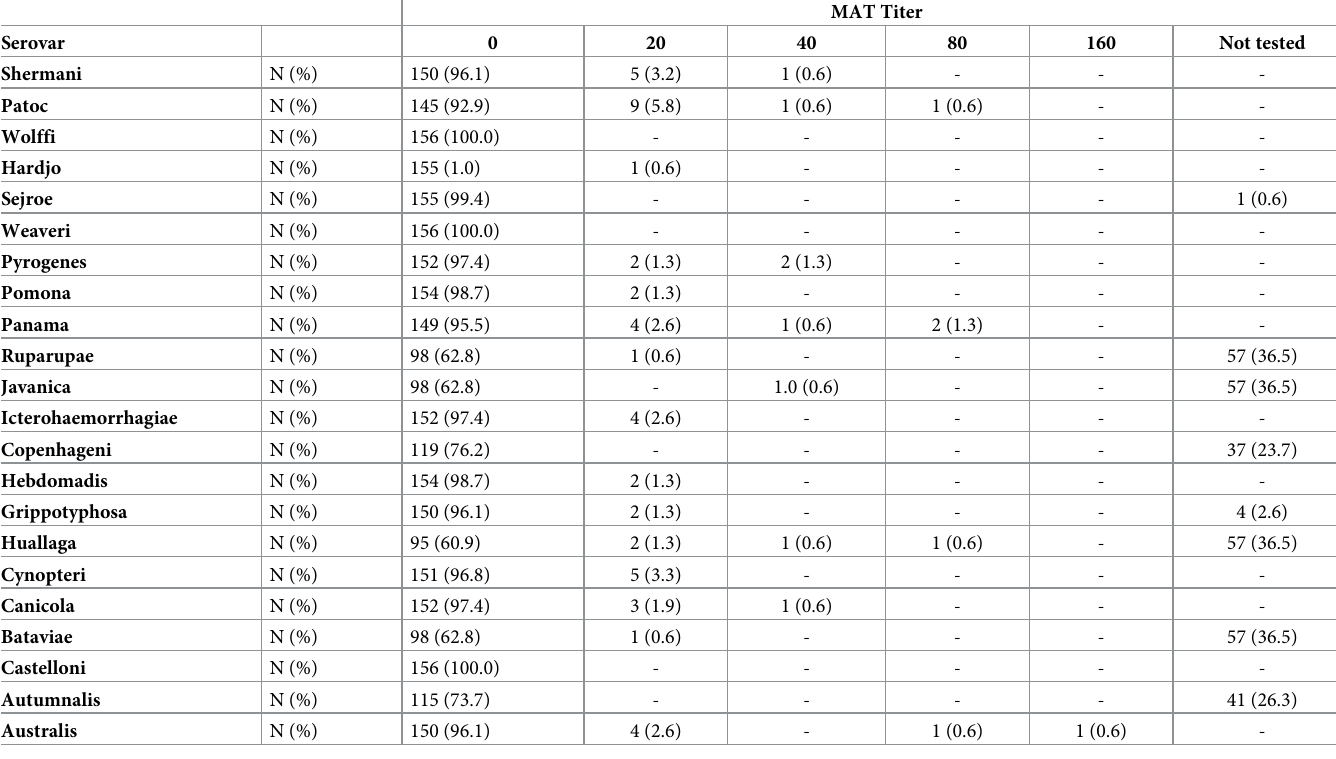
Table 5. Distribution of Microscopic Agglutination Test (MAT) antibody titer of 156 serum samples originating from the Colombian Wiwa tribe against the Lep- tospira serovar panel listed below (strains and serogroups are listed in Table 3). A MAT titer cut-off of � 1:100 was classified as seropositive. Given the large serovar panel, the quantity of serum was not always sufficient to test all samples against all serovars. The number and percentage of samples not tested for a given serovar are visible in the last